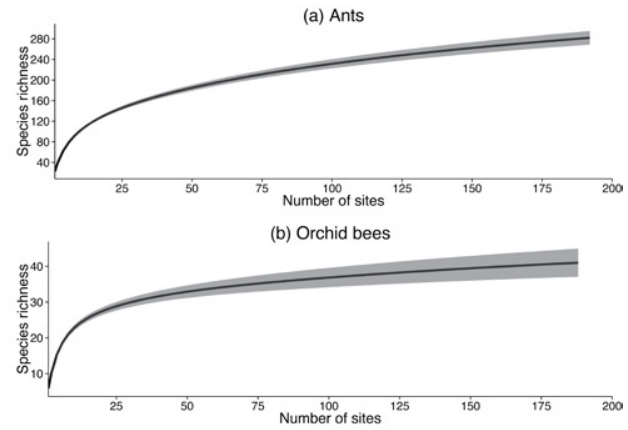
Fig 2 . Species accumulation curves for both studied taxonomic groups. Each curve was drawn after 10.000 randomisations of original data and the shaded area represents the standard deviation. In the x-axis we have number of sampled transects, in the y-axis, accumulated species richness.